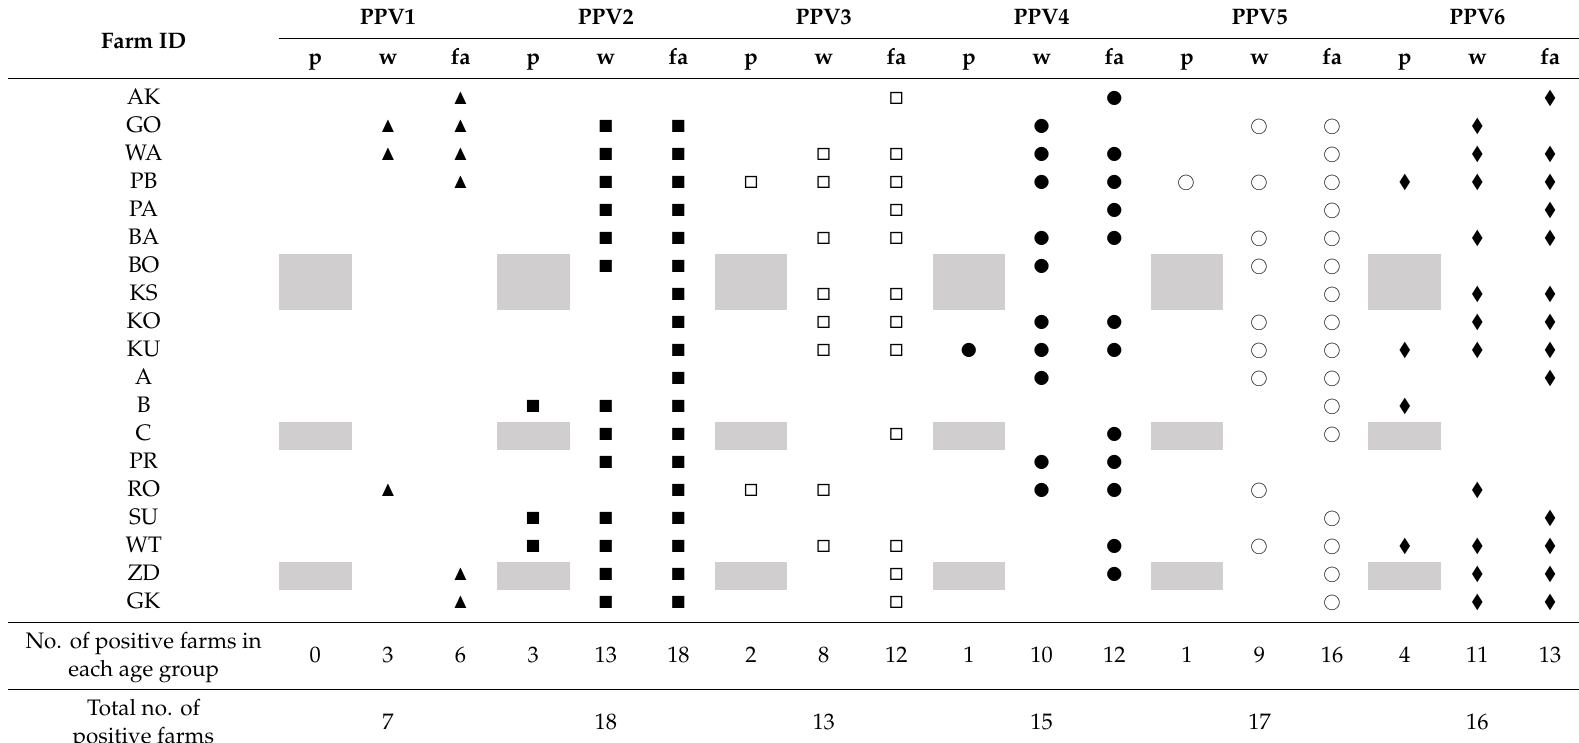
Table 1. The detection and coexistence of porcine parvoviruses 1–6 (PPV1–PPV6) in di ff erent age groups of pigs (piglets: 3–4 weeks old, weaners: 5–8 weeks old, and fatteners: ≥ 9 weeks old) in 19 farms. The group of piglets (p), weaners (w) or fatteners (fa) was considered as positive if at least one sample type (oral fluid, serum or feces) was positive for PPV1 –PPV6. The age groups positive for PPV1-PPV6 are marked with symbols: (cid:78) —PPV1, (cid:4) —PPV2, (cid:3) —PPV3, (cid:8)